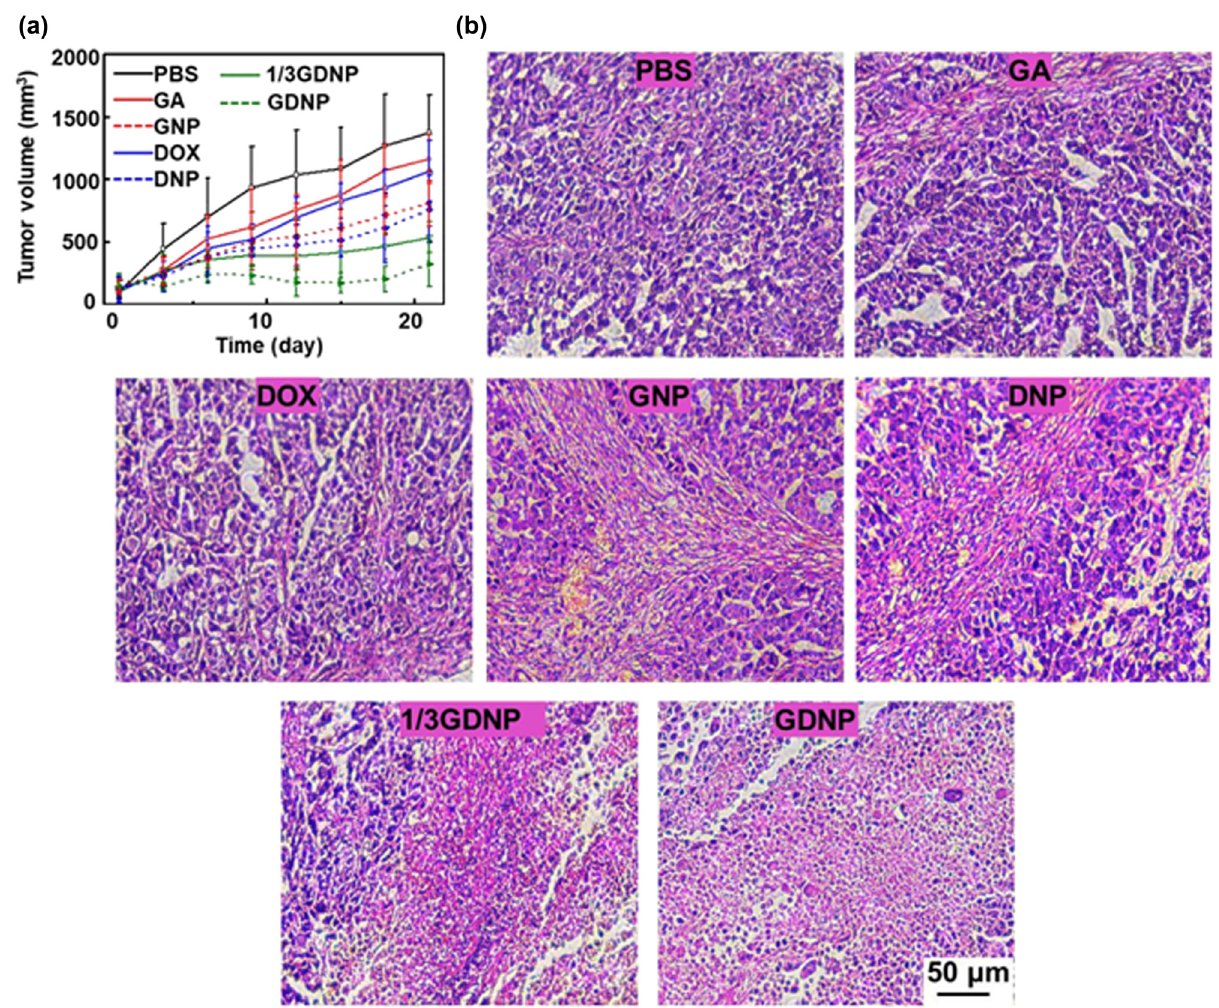
Figure 8: In vivo demonstration of the antitumor e ffi ciency of the drug - encapsulated bionanomaterials: ( a ) Free DOX and GA slightly inhibited the tumor growth as compared with the control treatment; ( b ) in a comparative assessment, larger necrotic regions were observed for the DNP and GNP groups than those of the free drugs. Meanwhile, the combined treatment with GDNP ( combination of DNP and GNP ) and 1/3 GDNP produced enhanced necrosis regions, which resulted in ≈ 90% induced apoptosis of cancer cells. Reproduced from ref. [ 134 ]